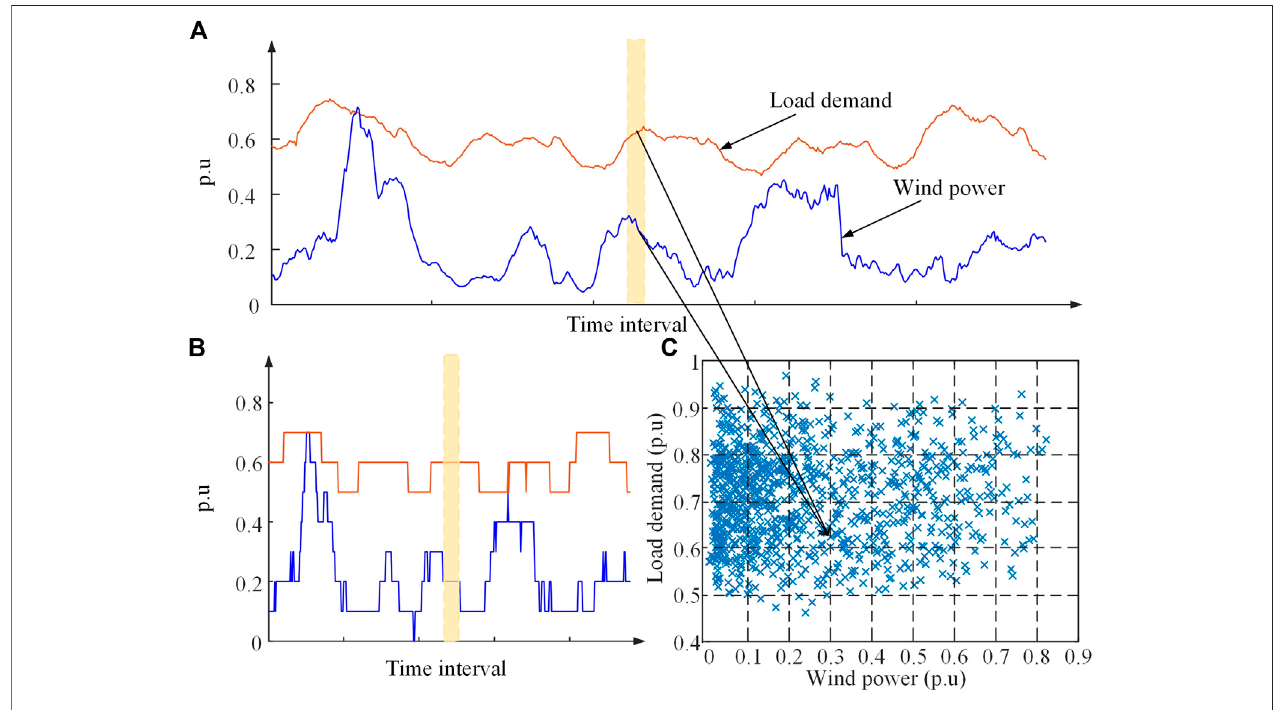
FIGURE 1 | Procedure of discretization and aggregation of time series